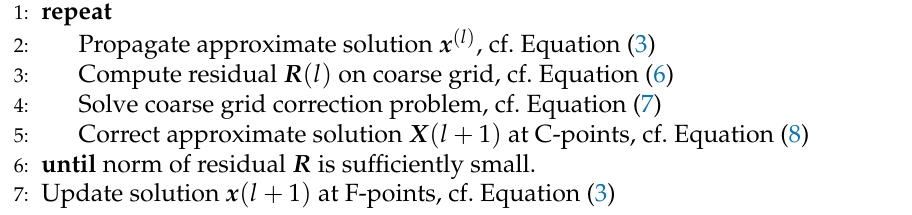
Algorithm 1 2-level MGRIT